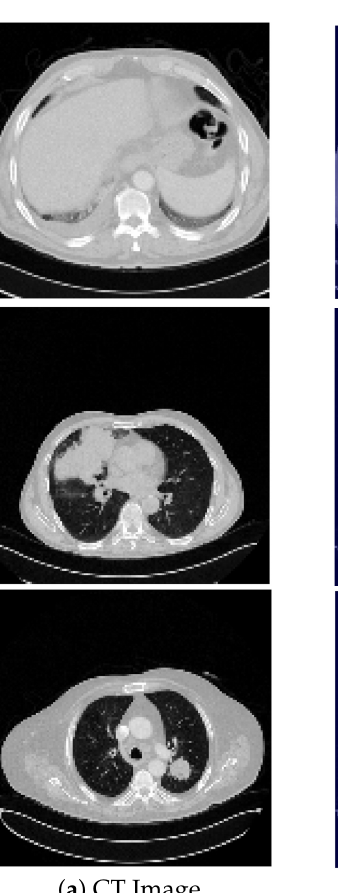
( a ) CT Image. ( b ) Ground Truth. ( c ) Predicted Mask. Figure 5. Examples of CHUSJ images, the ground truth and predicted mask. The first row is an example in which the model fails to correctly segment the pulmonary base; and second and third rows are examples in which the model does not segment the high density tumor